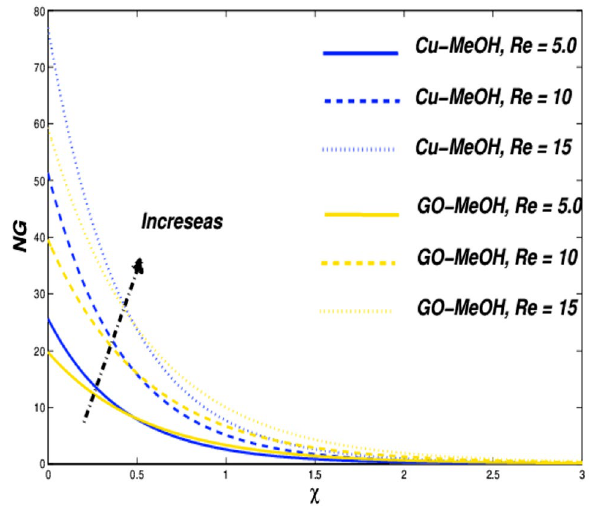
Figure 26. Entropy variation versus Re .